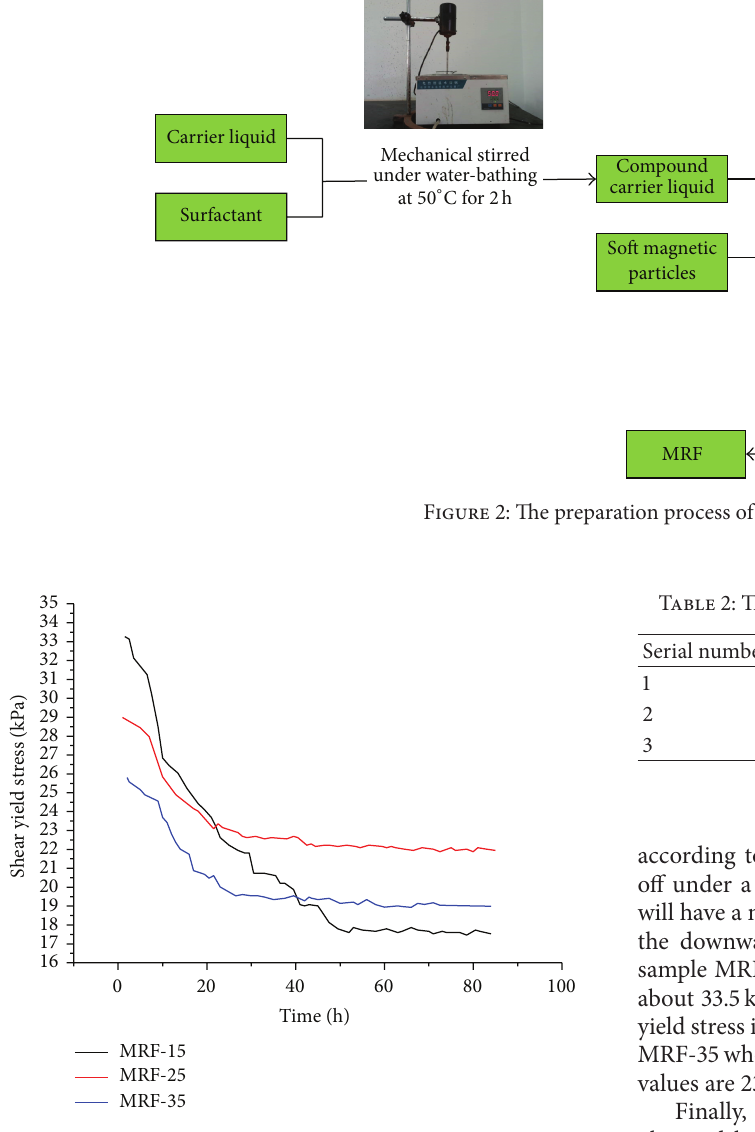
Figure 3: Relationship between shear yield stress and working time.